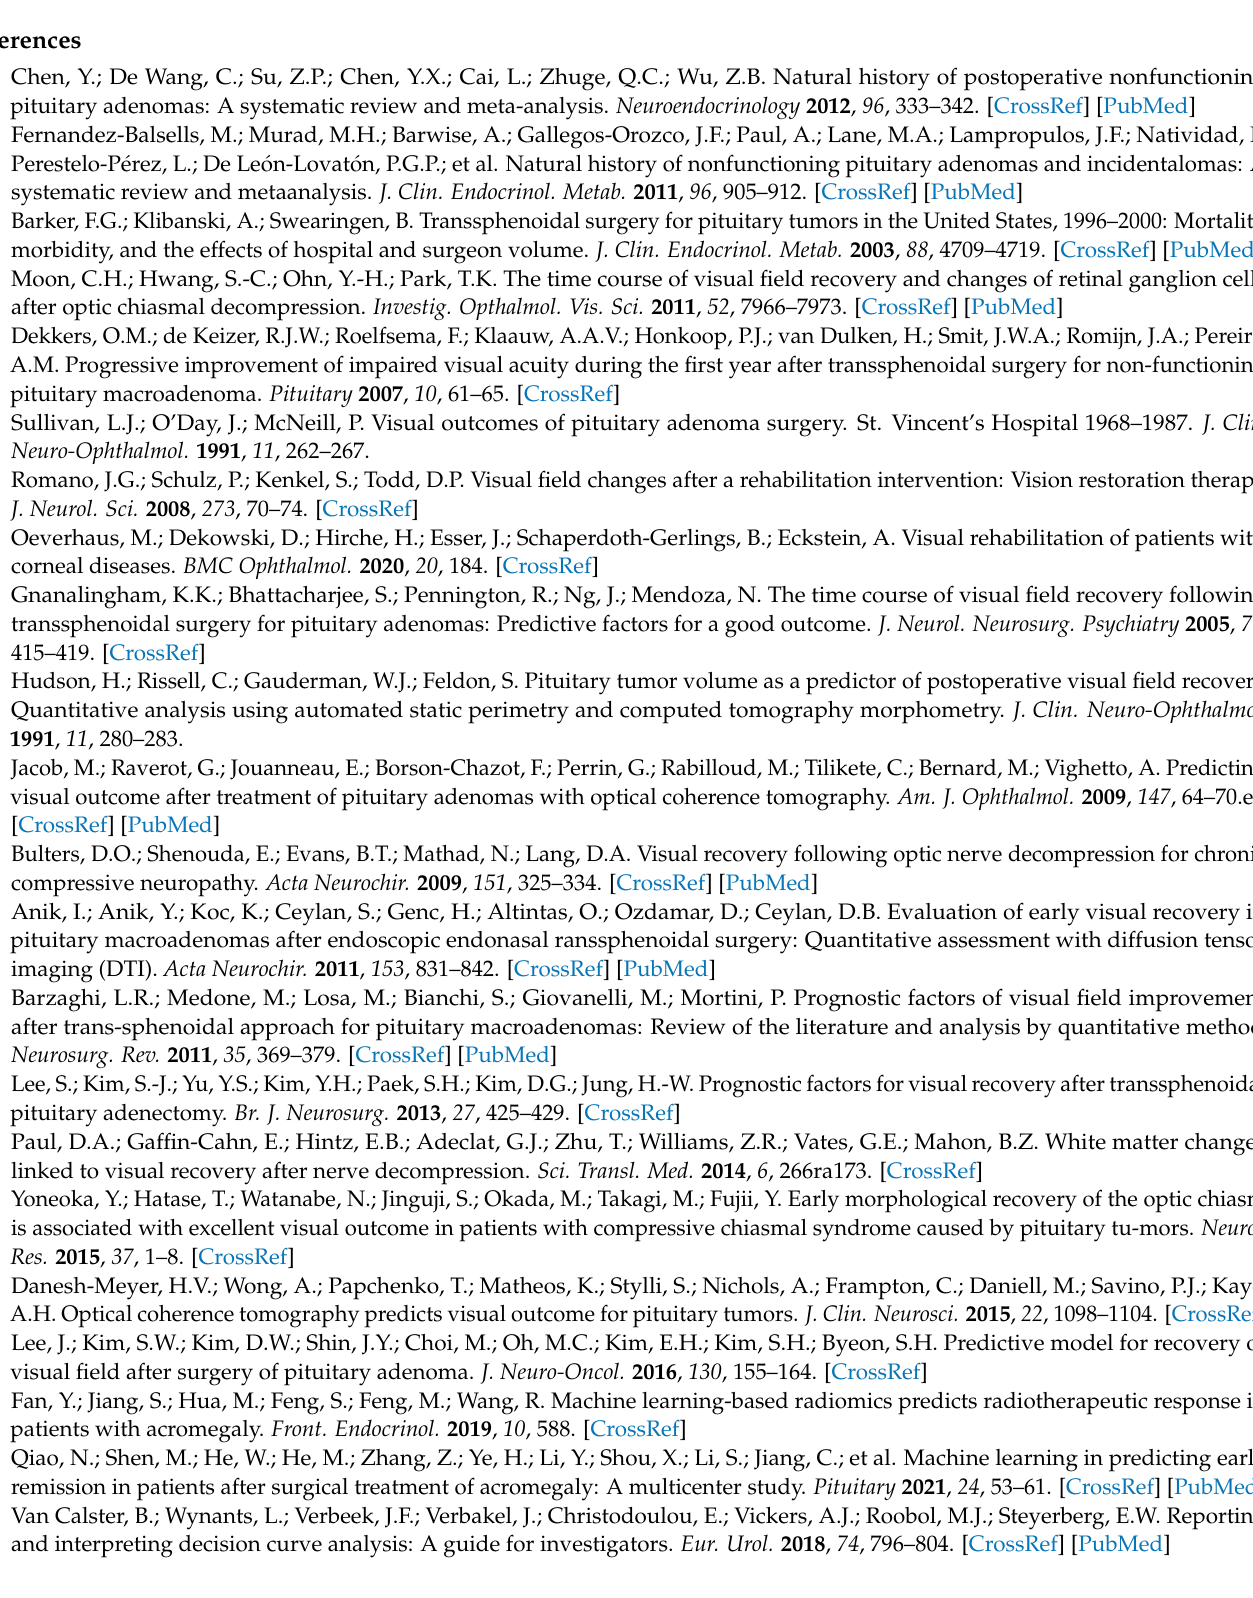
Availability of Data and Material: De-identified data are available upon request. Code Availability: All statistical analyses were completed in R software version 3.4.2, and code is available upon